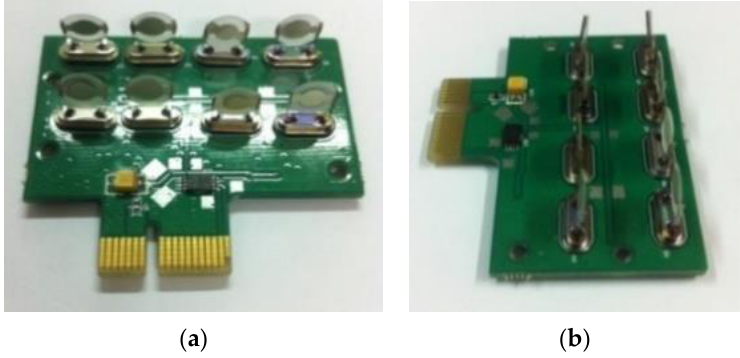
Figure 5. Image of the QCM sensor array. ( a ) front view; ( b ) slide view.